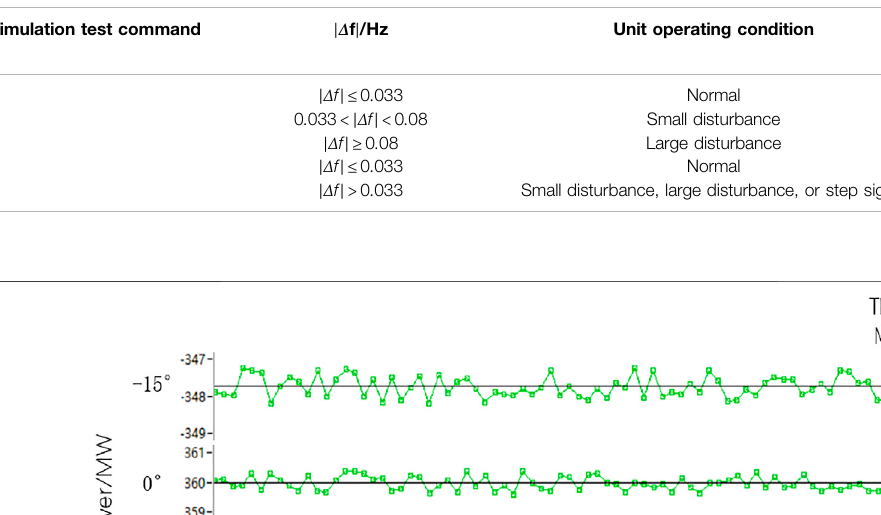
TABLE 1 | Frequency disturbance decision table.